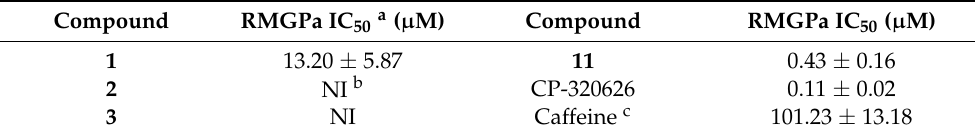
Table 1. Inhibition of rabbit muscle glycogen phosphorylase a (RMGPa) by probes 1 – 3, and Table intermediates.